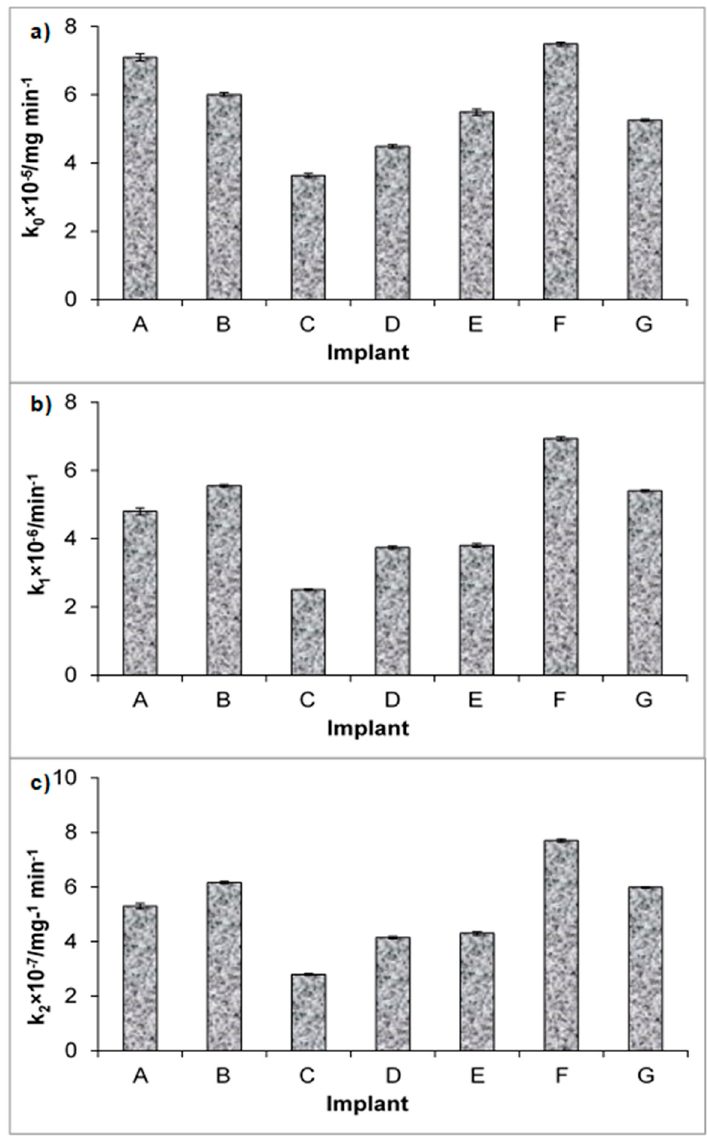
Figure 3. Comparison between the values of the release rate constants obtained by fitting the experimental data to: ( a ) zero-order kinetics, ( b ) first-order kinetics, ( c ) second-order kinetics.